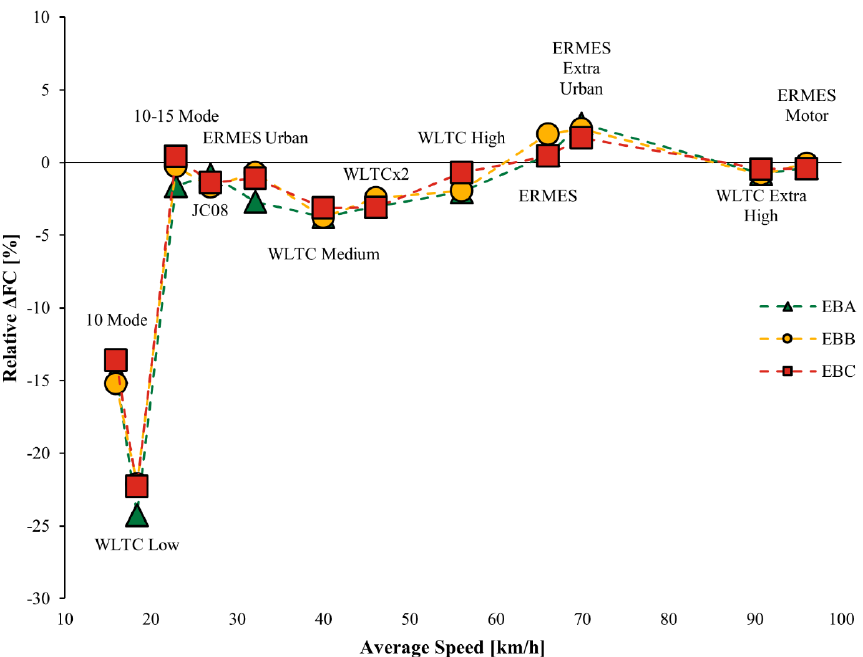
Figure 7. Fuel consumption change in ECMS algorithm types vs. Rule Based algorithm case for different cycles. EBA: ECMS Based Type A, EBB: ECMS Based Type B, EBC: ECMS Based Type C .